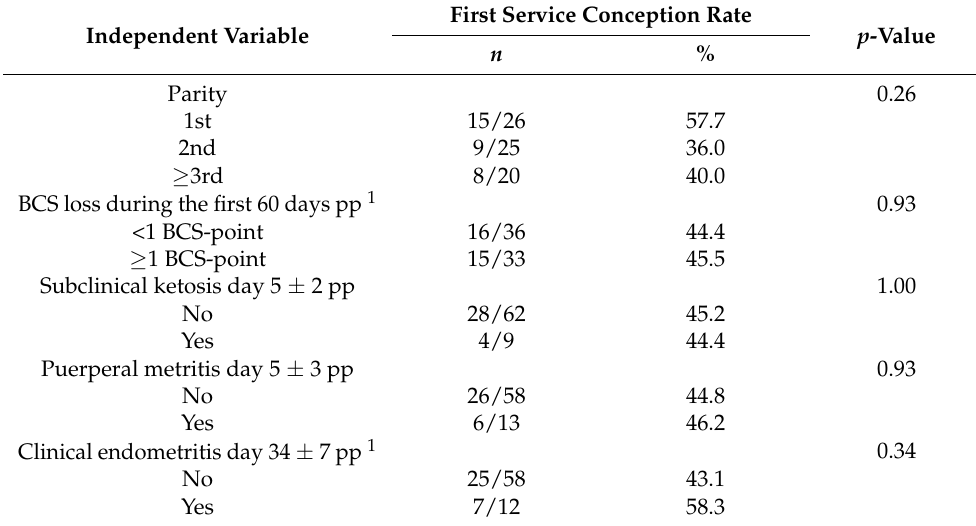
Table 2. Univariate analysis of the effect of lactation number, body condition score (BCS) loss and postpartum (pp) diseases on the first service conception rate of all cows ( n = 71). The number of pregnant animals and the total number within the group are given in each category ( n ), and the percentage of pregnant animals (%) is